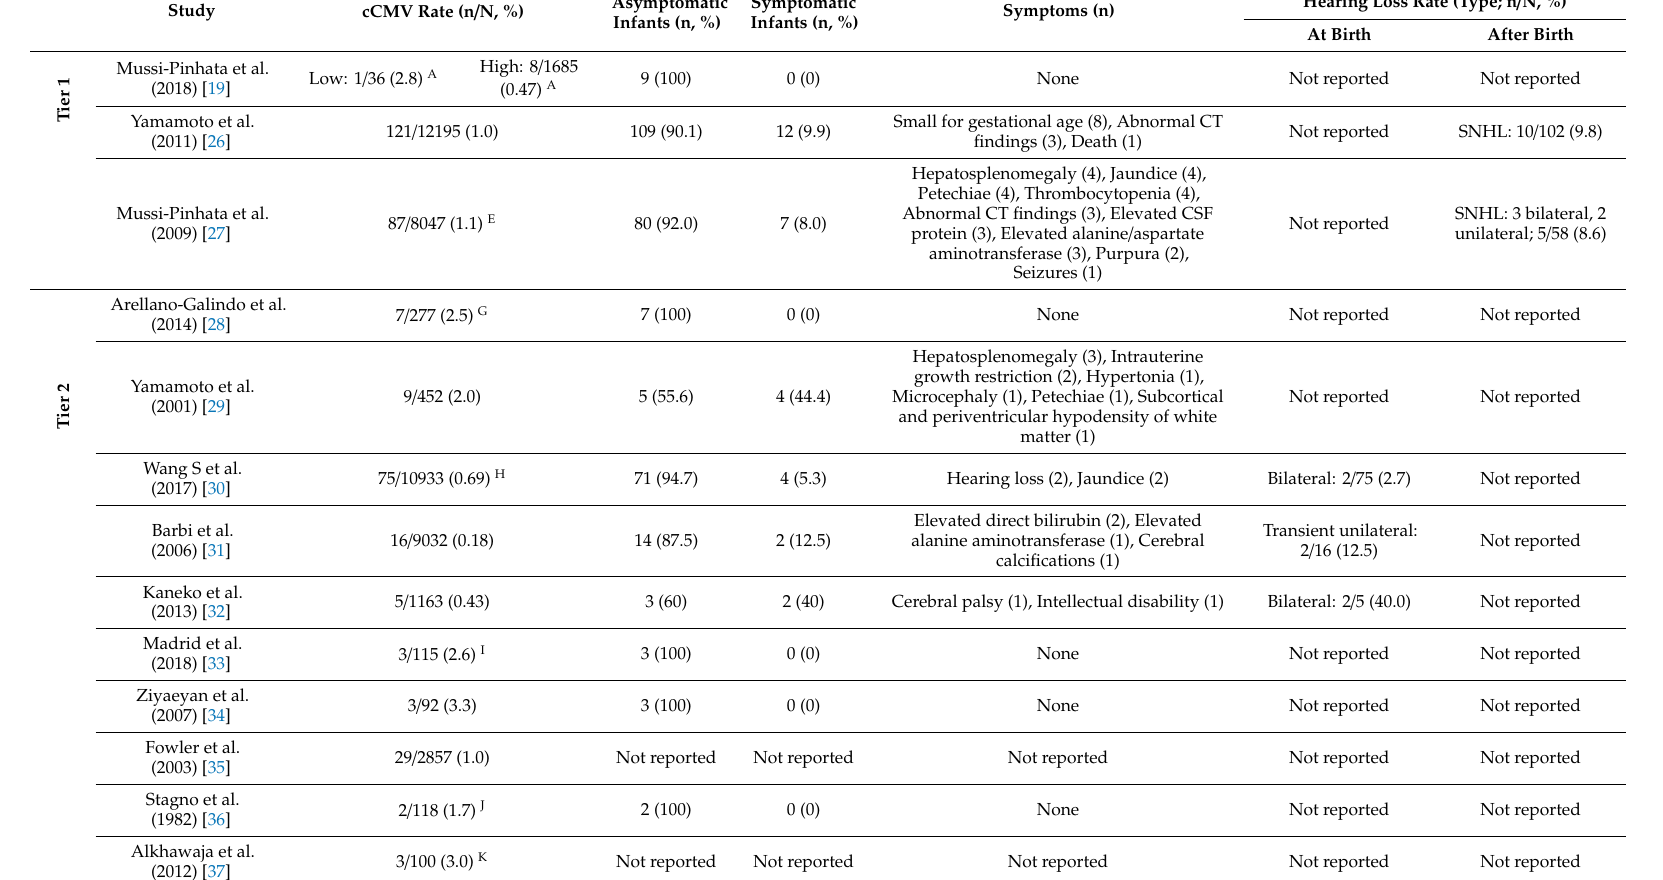
Table 2. Summary of selected studies cCMV birth prevalence and symptoms in highly seroprevalent